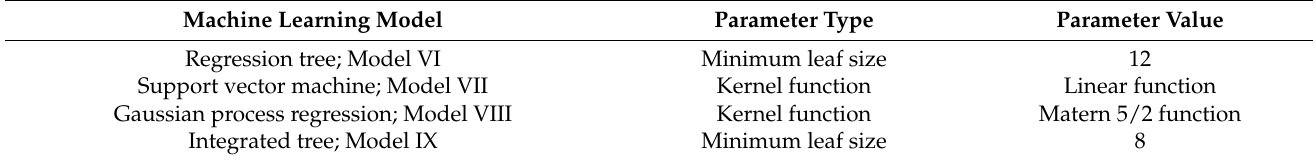
Table 4. Important parameters of the machine learning